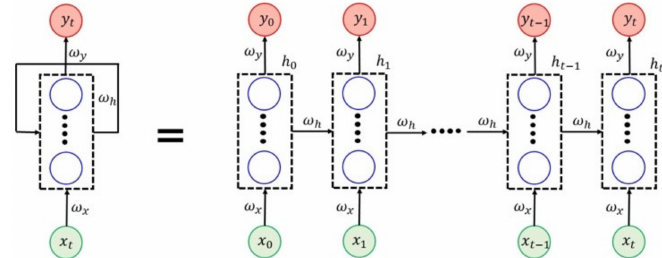
Figure 5. Schematic for recurrent neural networks (RNNs).